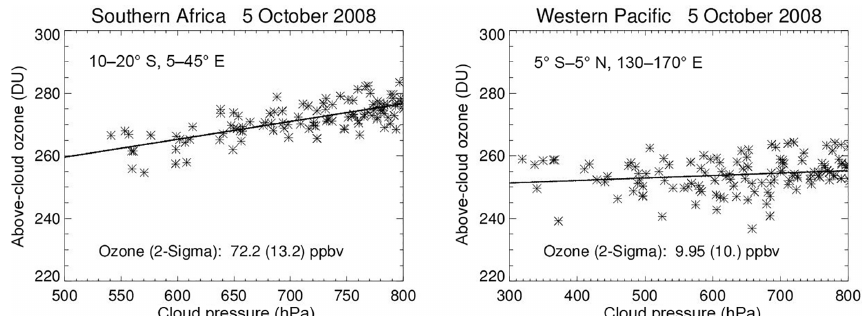
Figure 2. Examples of the ensemble cloud slicing technique using OMI measurements of above-cloud column ozone and cloud pressure (see text).